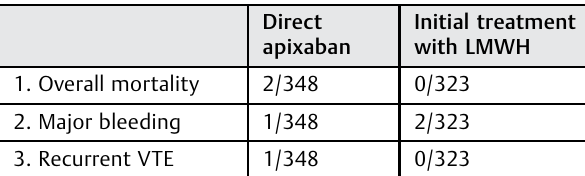
Initial treatment Direct apixaban with